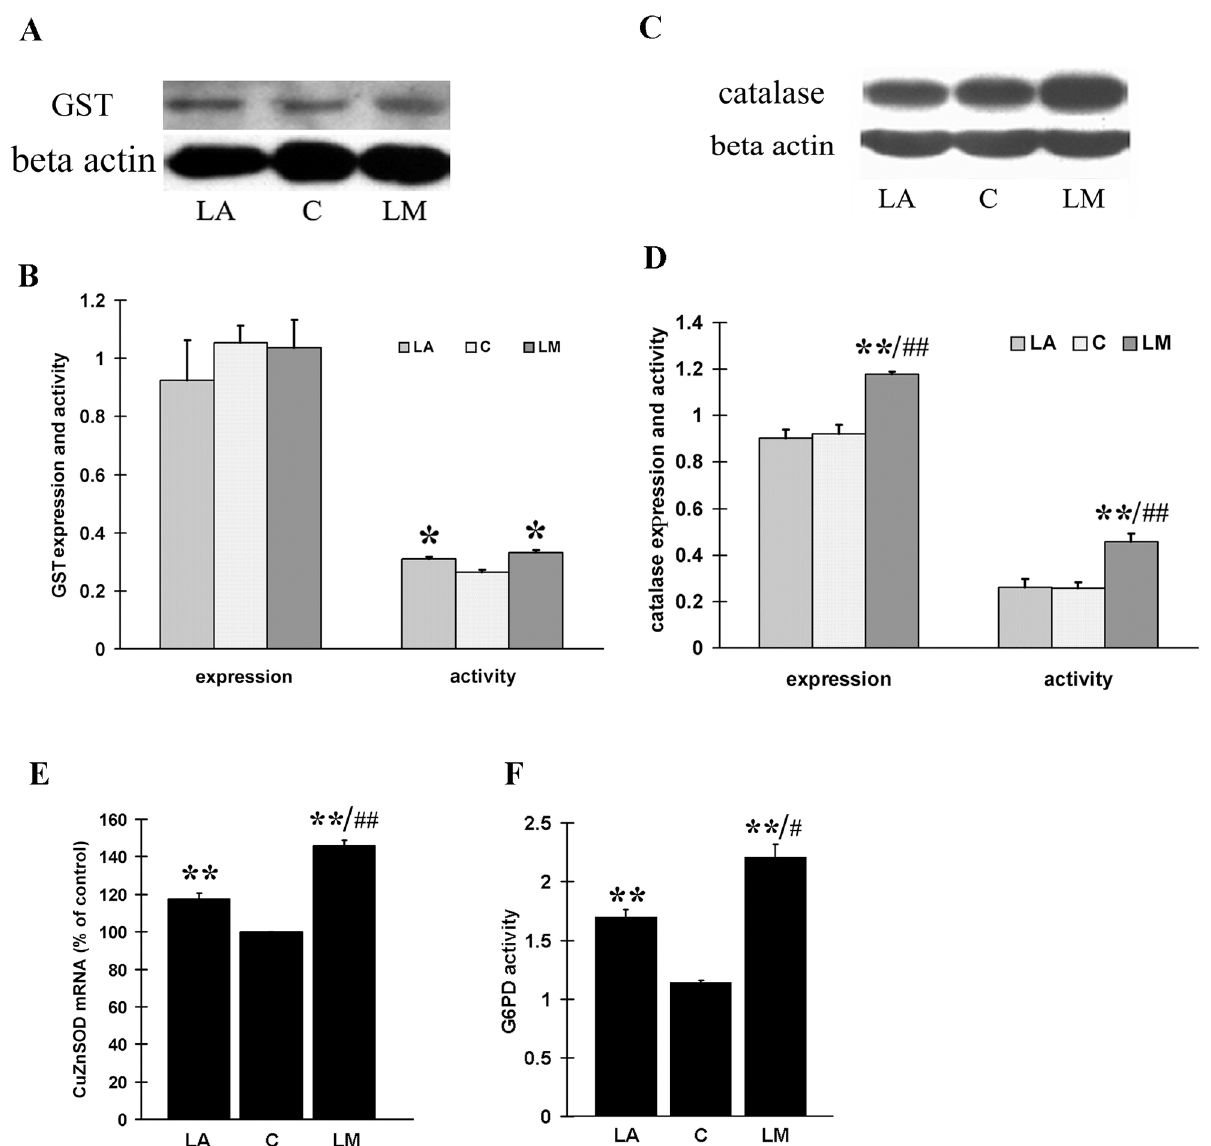
Fig 5. The effects of LM and LA on expression and activity of GST, catalase, Cu/ZnSOD and G6PD. ARPE-19 cells were treated with 40 μ mol/L LM or LA for 48 h. (A) A representative image of total GST expression detected by western blot. (B) Quantitative analysis of GST expression (4 independent experiments) and activity (5 independent experiments). (C) A representative image of catalase expression detected by western blot. (D) Quantitative analysis of catalase expression (4 independent experiments) and activity (3 independent experiments). The results are expressed in arbitrary units and each experiment was performed in duplicate. (E) Transcriptional expression of Cu/ZnSOD. Real time RT-PCR was employed to measure expression levels of Cu/ ZnSOD. Results (from 5 independent experiments) are expressed as ratios of Cu/ZnSOD to 18SrRNA. (F) G6PD activity was measured as described in Methods. Values are means ± SEM of three independent experiments. All statistical significance were established by one way ANOVA followed by the Tukey test. * p < 0.05, ** p < 0.01 vs. untreated controls (0 μ mol/L), # p < 0.05 vs. LA, and ## p < 0.01 vs.